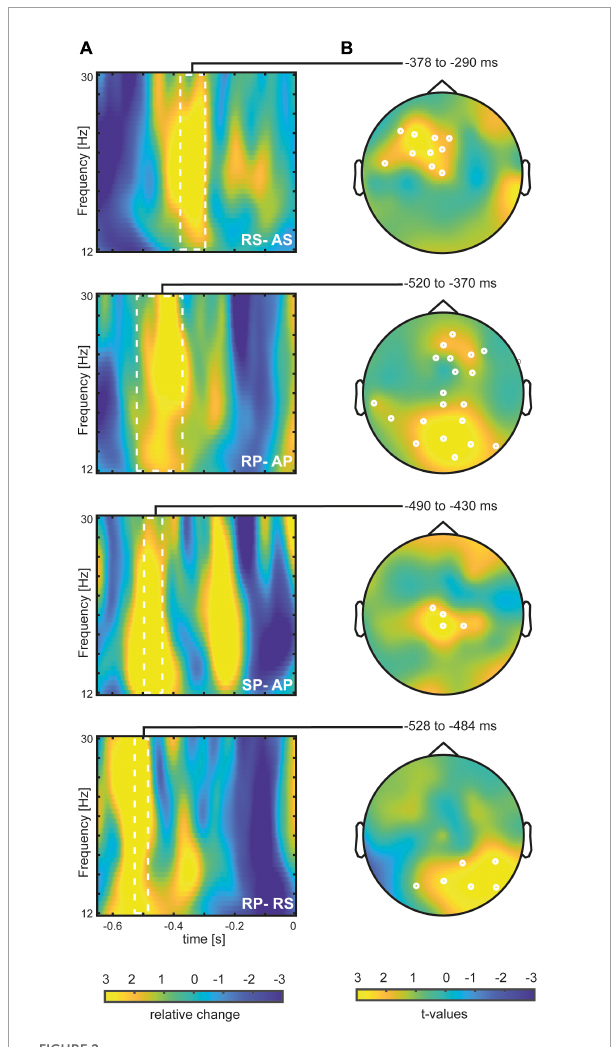
FIGURE2 Differences between experimental conditions: Panel (A) pre-stimulus beta power grand average across significant electrodes. White rectangles indicate significant time windows. Beta power is plotted as relative change from the mean in percent. Panel (B) Topographical distributions of the t -values of the pre-stimulus beta power effects. White circles indicate electrode sites that belong to the significant cluster. Upper row: RS-AS condition; second row: RP-AP condition; third row: SP-AP condition; bottom row: RP-RS condition; RP, rhythmic pedaling; AP, arrythmic pedaling; RS, rhythmic sitting; AS, arrhythmic sitting; SP, self-generated pedaling.